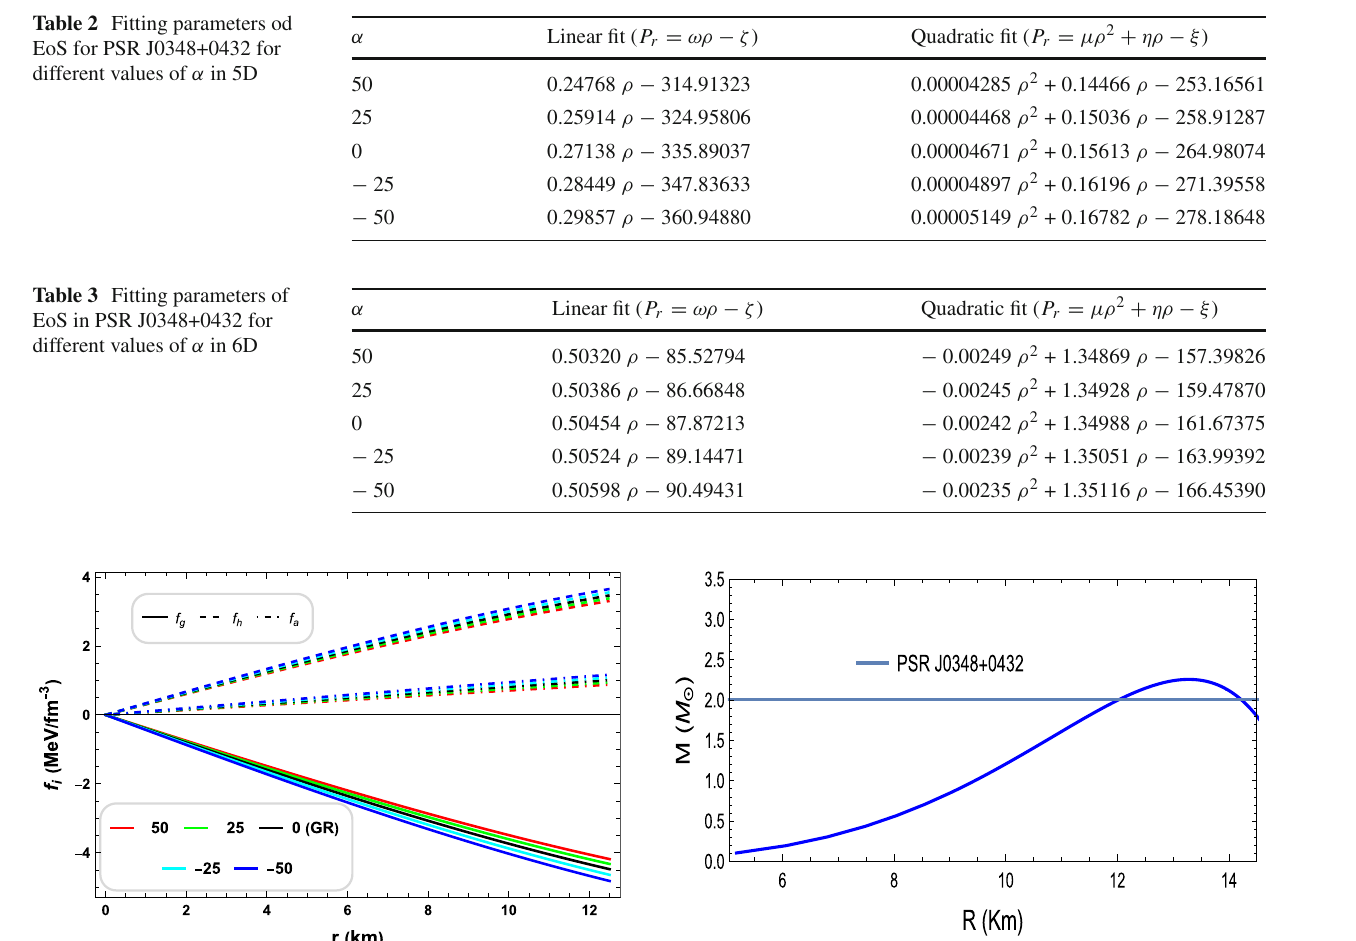
Fig. 18 Mass–radius (M–R) relation in